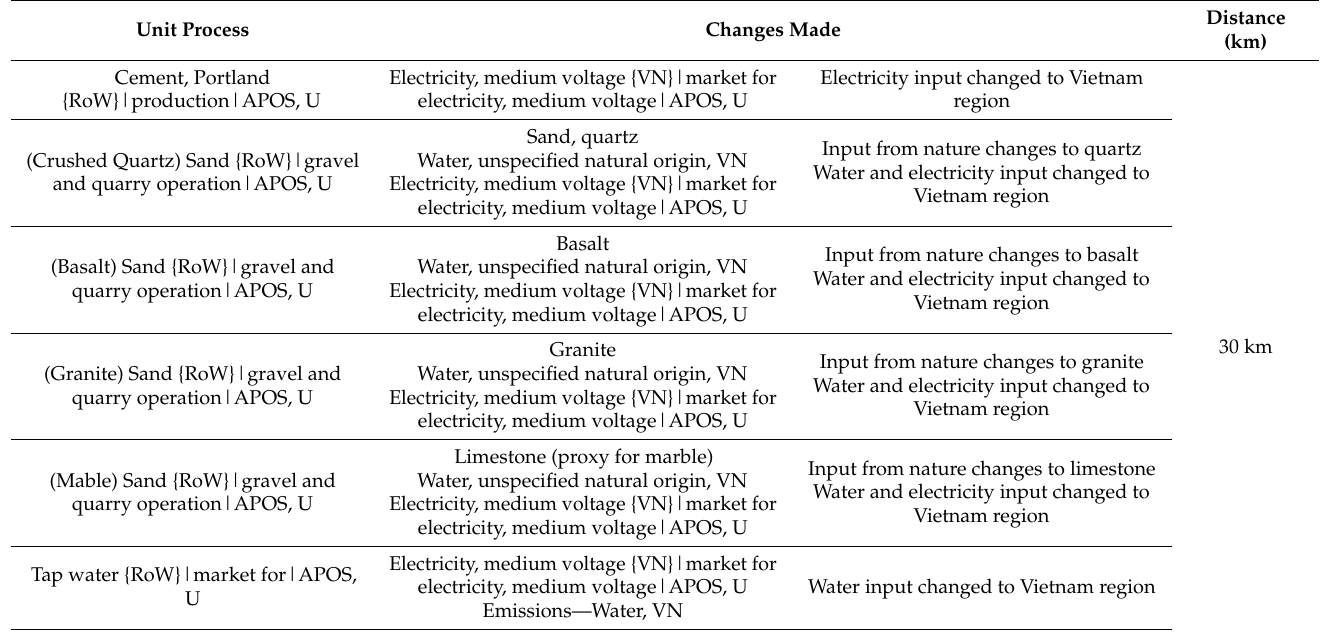
Table 5. Unit Processes used for concrete LCA from